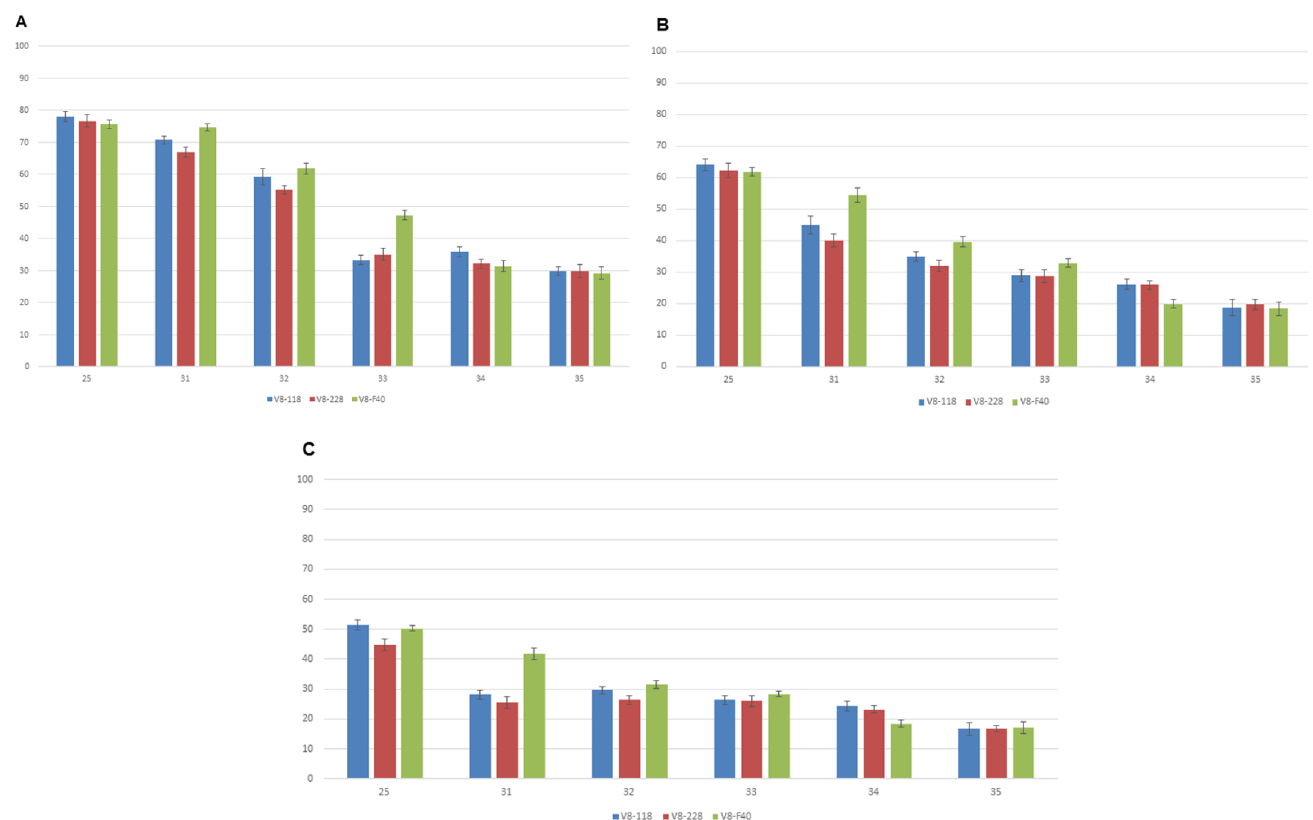
Fig 3. Comparison of the three strains (V8-118, V8-228 and V8-F40) in five different temperatures (25, 31, 32, 33, 34 and 35°C), according to the tsl screening described in Table 2 (standard errors are indicated). (A) egg hatch (per 100 eggs), (B) pupation rates (per 100 eggs) and (C) adult emergence (per